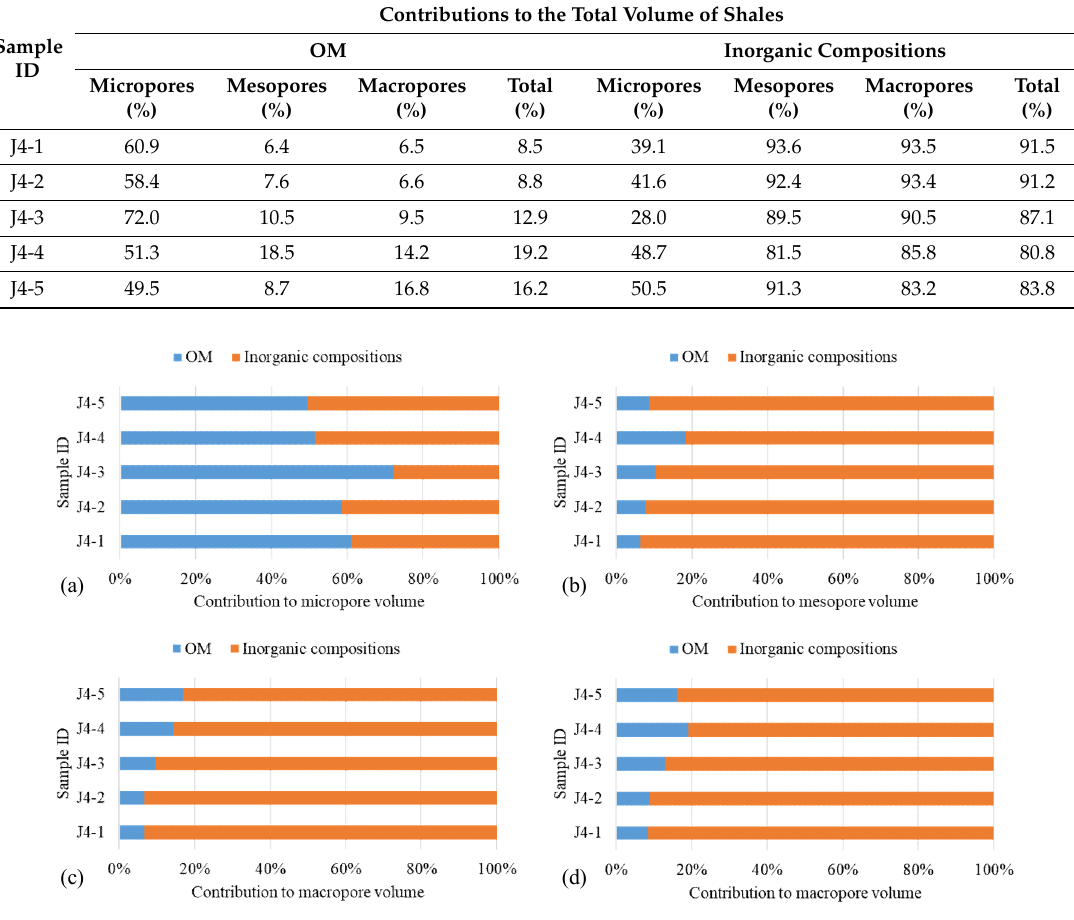
Figure 8. Contributions of OM and inorganic compositions to ( a ) micropore volume, ( b ) mesopore volume, ( c ) macropore volume and ( d ) and total pore volume of W-L shale samples.